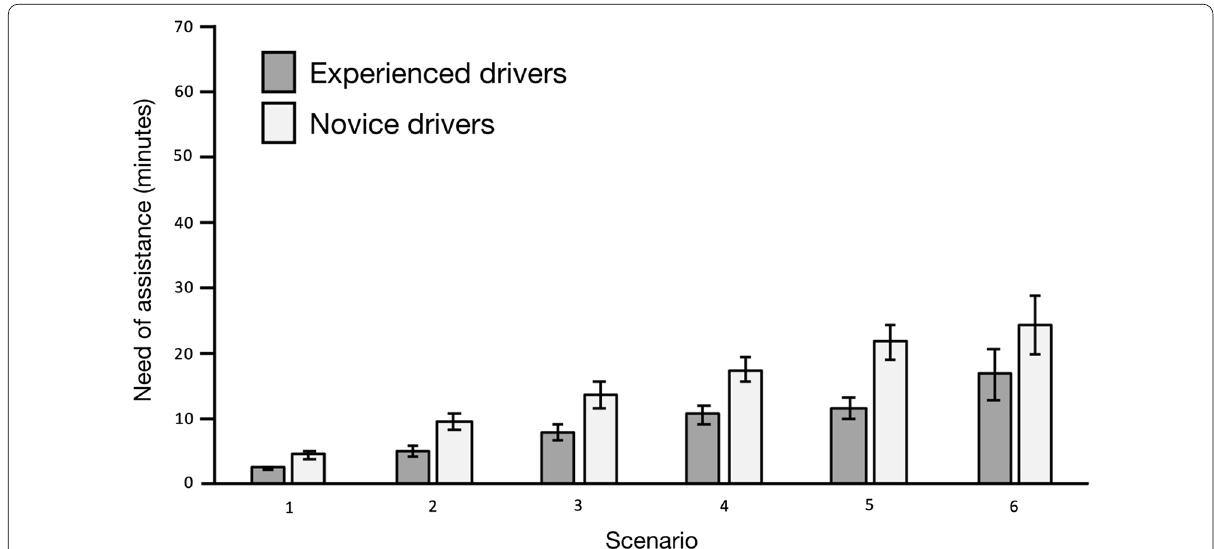
Fig. 2 Mean estimated time required for assistance (